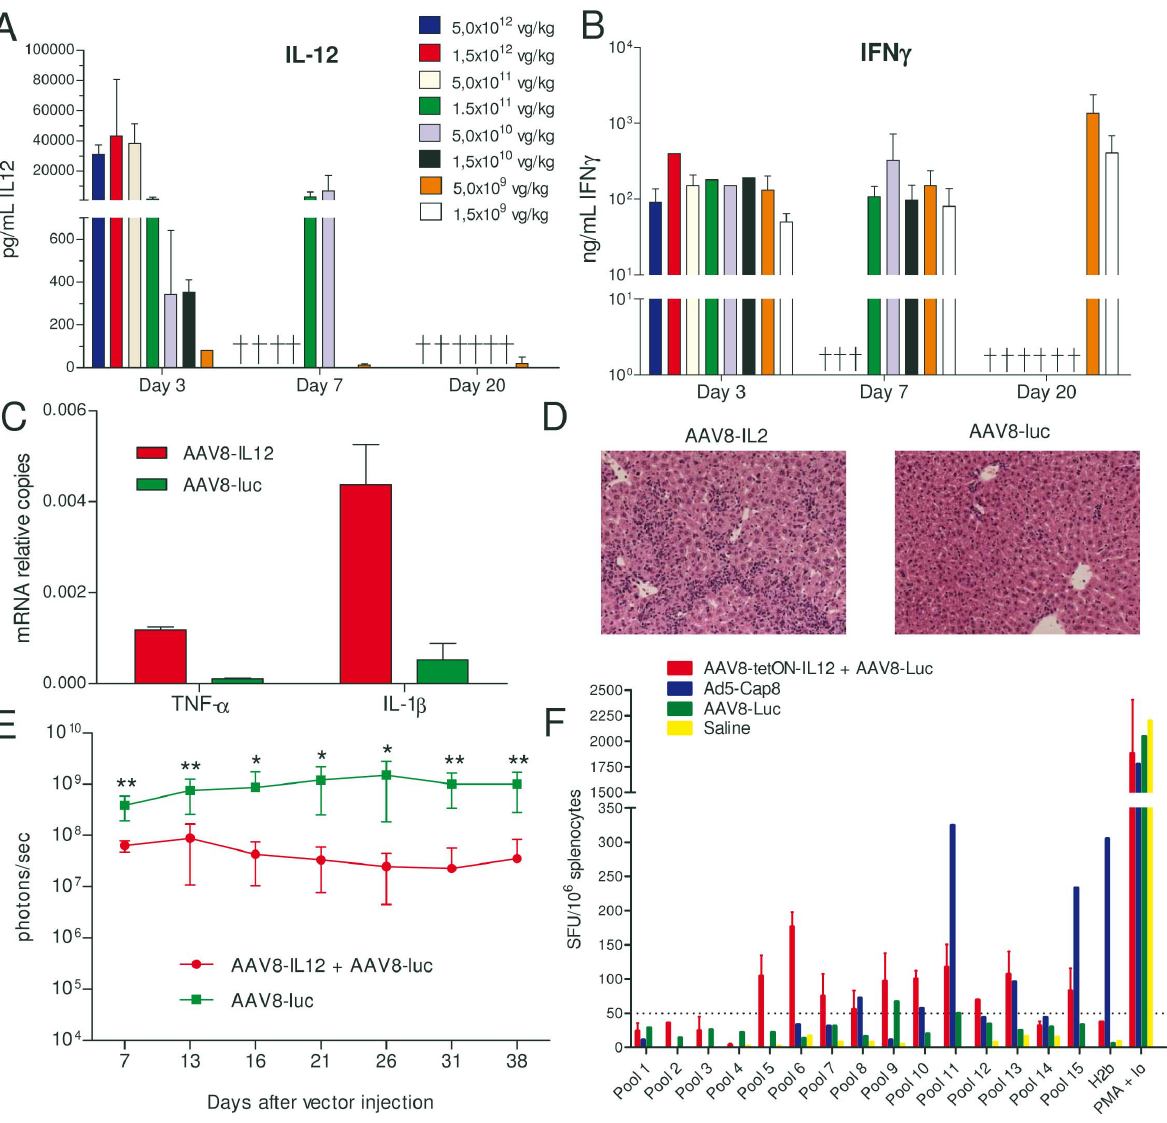
Figure 1. AAV8-IL-12 induces liver inflammation, enhances immune response against AAV8 but do not eliminate transduced hepatocytes. C57BL/6 female mice (n=5) received intravenously (IV) different doses of AAV8-IL12 vector and IL-12 A) and IFN- c B) concentration in serum was analyzed by ELISA at different time points after vector injection. C) C57BL/6 female were IV injected with AAV8-IL-12 or AAV8-luc vectors at a dose of 1.5 6 109 vg/kg, 21 days after injection TNF a and IL-1 b expression levels were analyzed in the liver by RT qPCR. D) Hematoxilin and eosin staining of liver sections. E) Animals were injected with an AAV8-luc vector at a dose of 2.5 6 1011 vg/kg with or without coadministration of an AAV8- IL12 vector at a dose of 1.5 6 109 vg/kg. Luciferase expression in the liver was followed for 38 days by in vivo bioluminescence imaging and quantification is represented as photons/second. F) C57BL/6 female mice received the AAV8-tetON-IL12 vector together with an AAV8-luc vector, or AAV8-luc vector alone, or an adenoviral vector expressing AAV8 capsid protein (Ad5-Cap8) or saline. Twenty days after vector injection, animals receiving AAV8-tetON-IL12 and AAV8-luc or AAV8-luc alone were treated with doxycycline (Dox) to induce IL-12 for 7 days expression and the immune response was analyzed 14 days after Tet removal. Animals receiving Ad5-Cap8 were sacrificed 10 days after vector injection. Splenocytes obtained from these mice were stimulated with different pools of peptides derived from the AAV8 VP1 capsid protein, the H2b peptide previously described for the AAV8 capsid protein, NSLANPGIA [10], or PMA plus ionomycin as positive control. AAV8-luc + AAV8-IL12 (Fig. 3E). The analysis of luciferase expression showed significant differences between the two groups indicating that both NK and T cells play a role in IL-12 mediated inhibition of transgene expression. Since IFN- c is the main mediator of IL-12 inhibitory activity we next analyzed the production of IFN- c . All the animals produced IFN- c after vector injection except RAG- c c 2 / 2 mice, which correlates with the absence of differences in luciferase expression (Fig.S1).